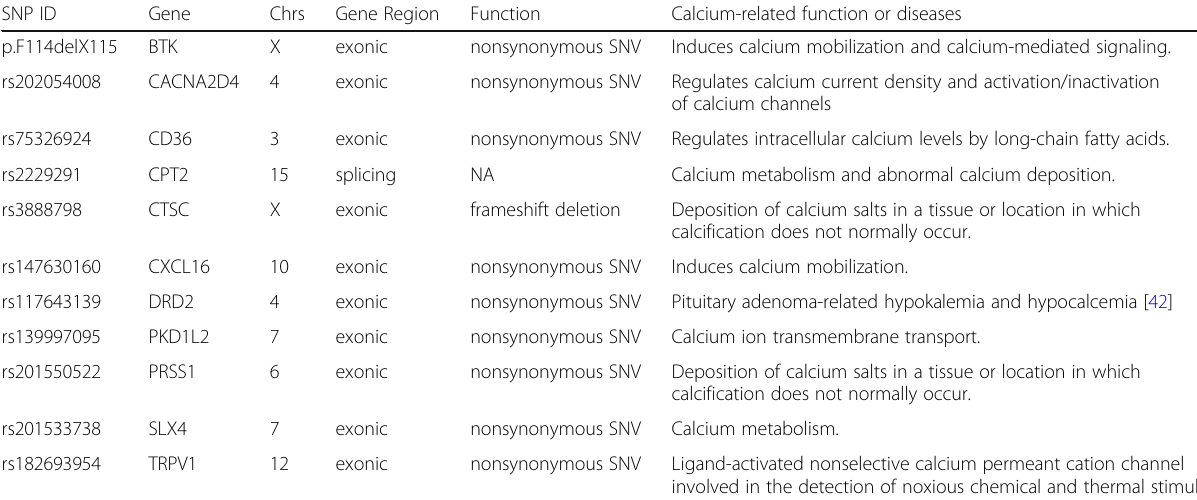
Table 2 Germline variants related to calcium metabolism